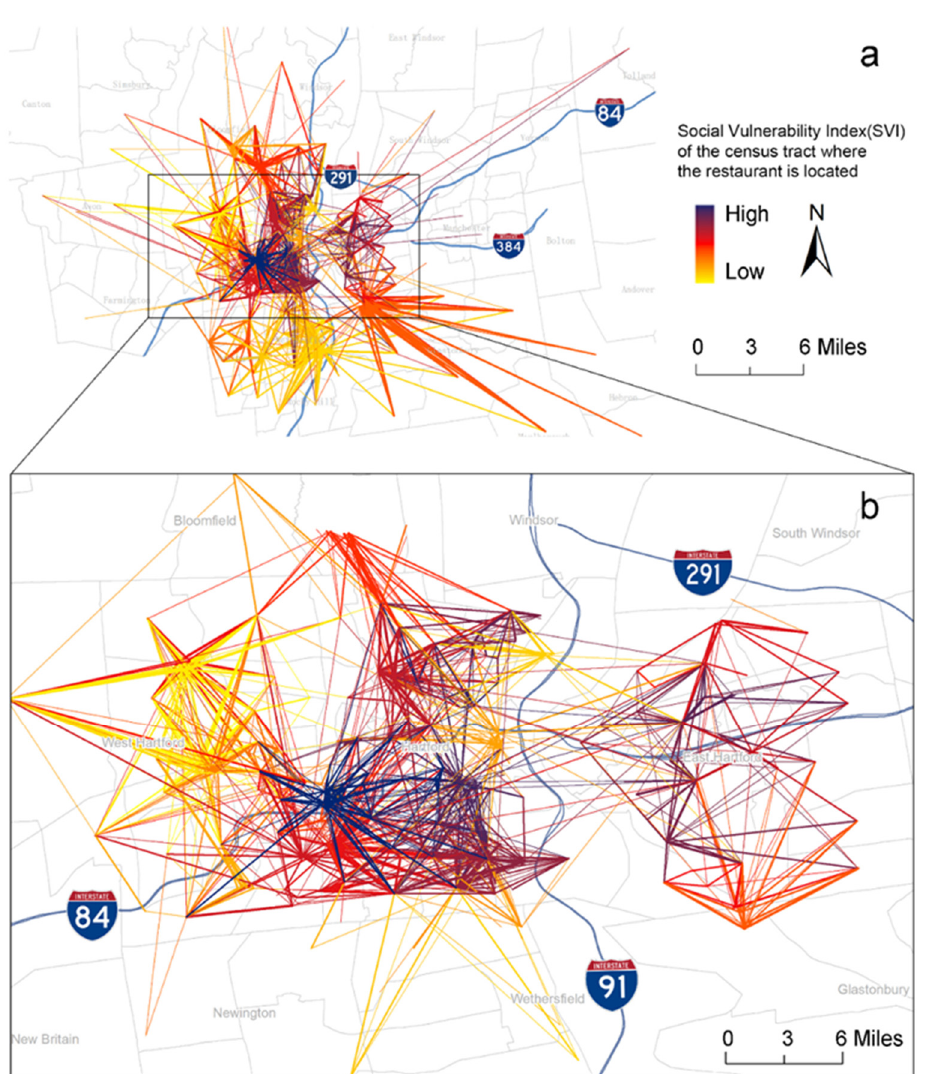
Figure 2. Restaurant-visit patterns in the Greater Hartford region. ( a ) shows overall restaurant-visit patterns in the Greater Hartford region, and ( b ) zooms into East Hartford, West Hartford, and Hartford. Each line connects a restaurant to a census tract. Line thickness indicates the number of visits; line color indicates the percentile-ranking of SVI for the census tract where the restaurant is located (darker means more socially vulnerable). Only relations with more than 41 visits (top 25% percentile) are included in the figure.